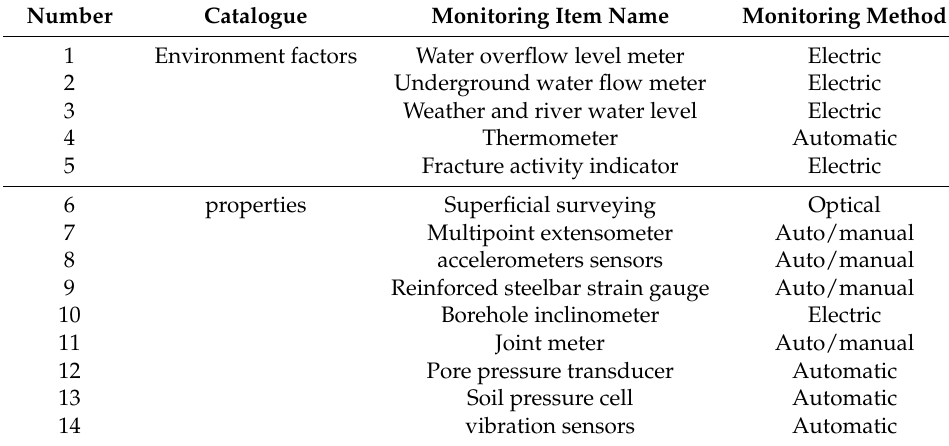
Figure 2. Diagram of the architecture of proposed safety information model consisting of key elements. Table 1. Slope health monitoring data in the database [27] .